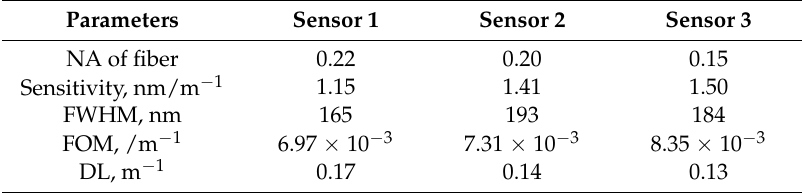
Table 1. Parameters comparison between three sensors using wavelength modulation.